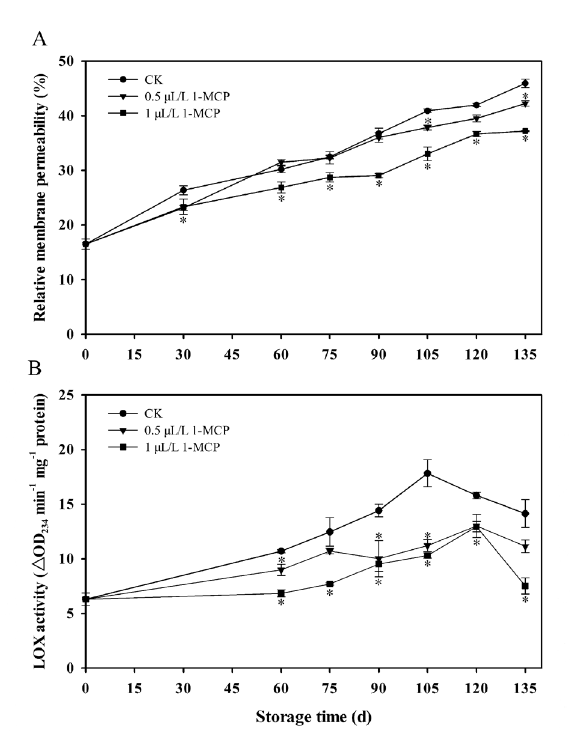
Fig. 4: Effect of 1-MCP on relative membrane permeability (A) and LOX activity (B) in ‘Wujiuxiang’ pear fruits during storage at 0 °C. The data are the means ± SE of three replicates. The vertical bars represent the standard errors of the means. Star represents significant difference ( P < 0.05).